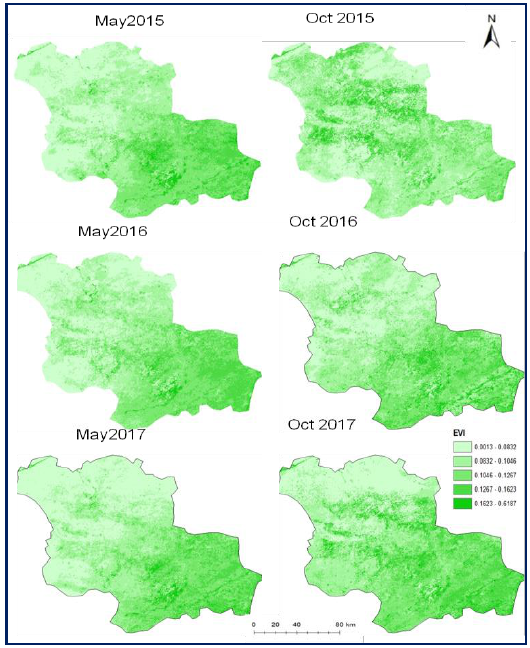
Fig.6: Temporal and spatial variation in EVI of the study